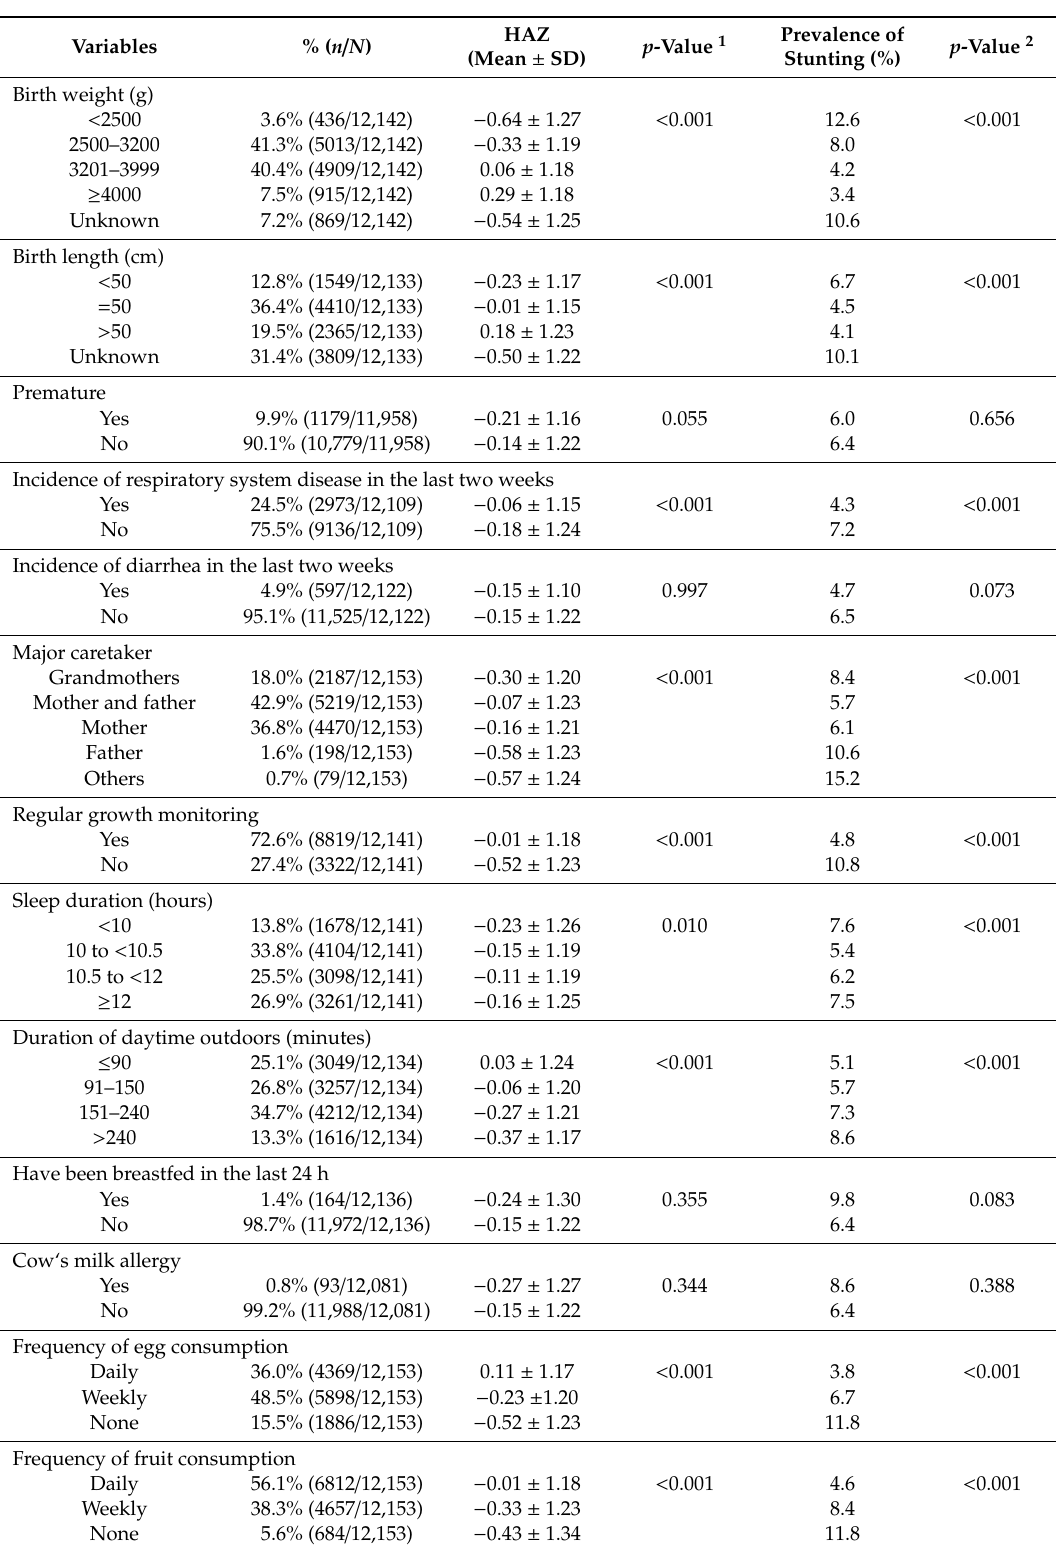
Table 2. The relationship between the health status and lifestyles and the HAZ and the prevalence of